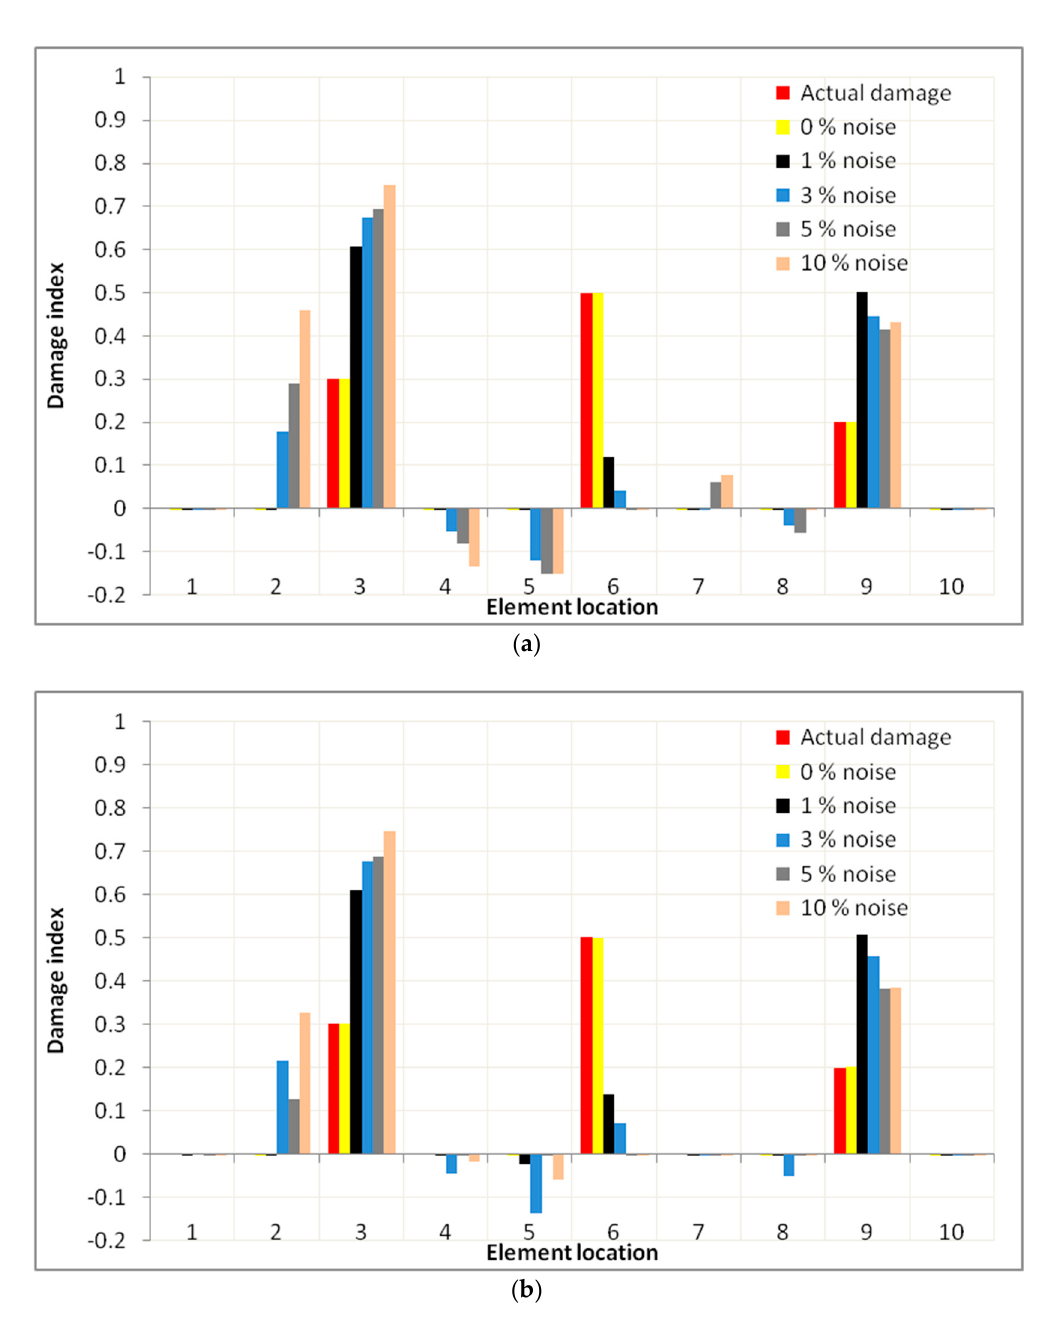
Figure 14. Damage distribution for Case 2 using Objective Function III with regularization for ( a ) noise both in frequency and mode shapes and ( b ) noise in mode shapes only.